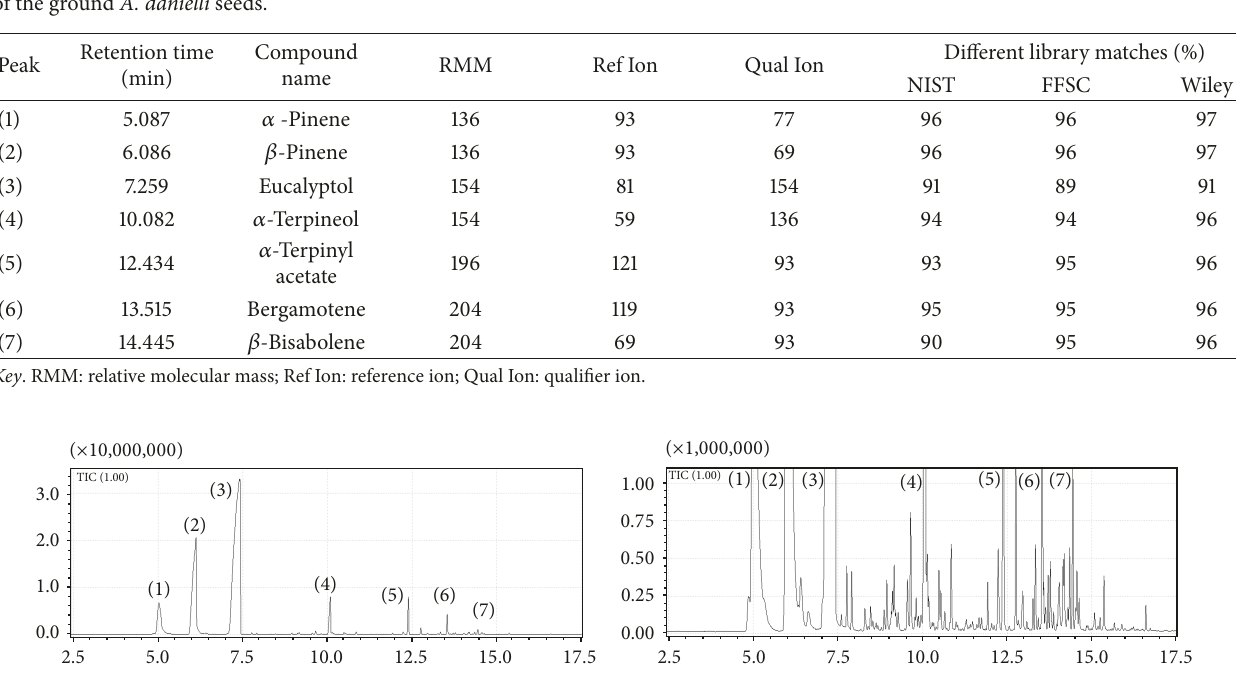
Table 1: Some chromatographic data and tentative annotation of the top ten most abundant VOCs obtained from the headspace extraction of the ground A. danielli seeds.